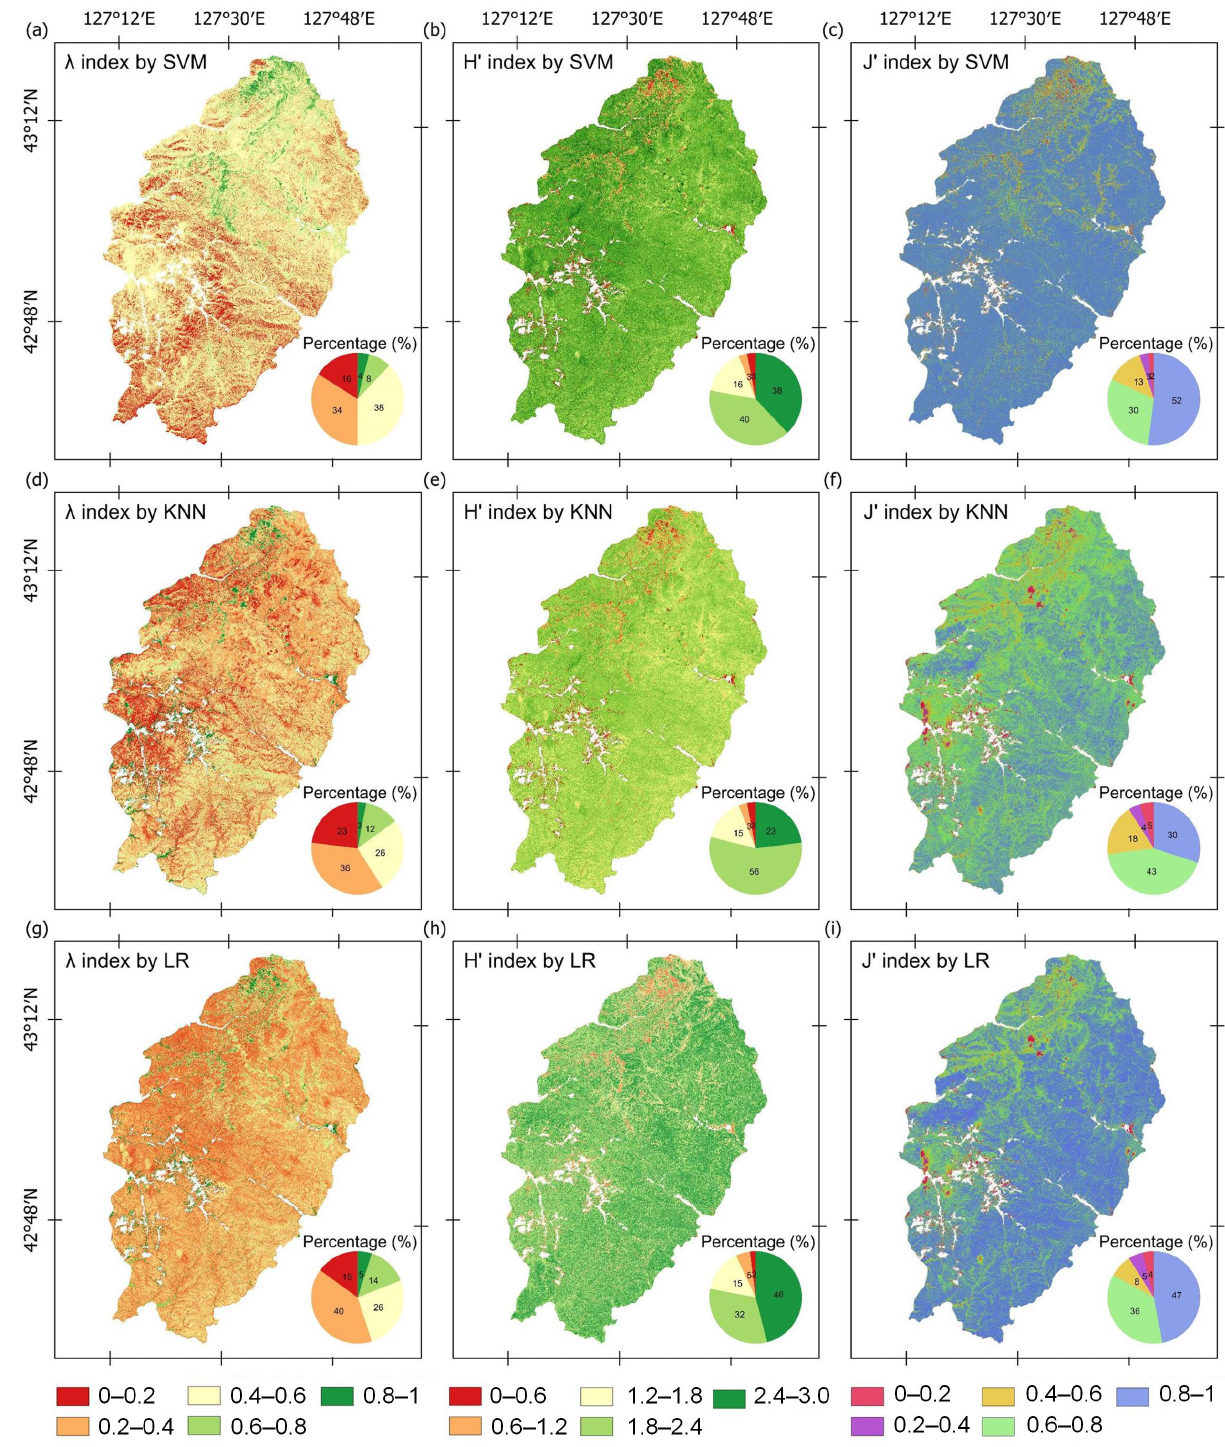
Figure A3. Predicted maps of three diversity indices (λ, H ′ and J ′) by SVM (a-c), KNN (d-f) and LR (g-i) models.